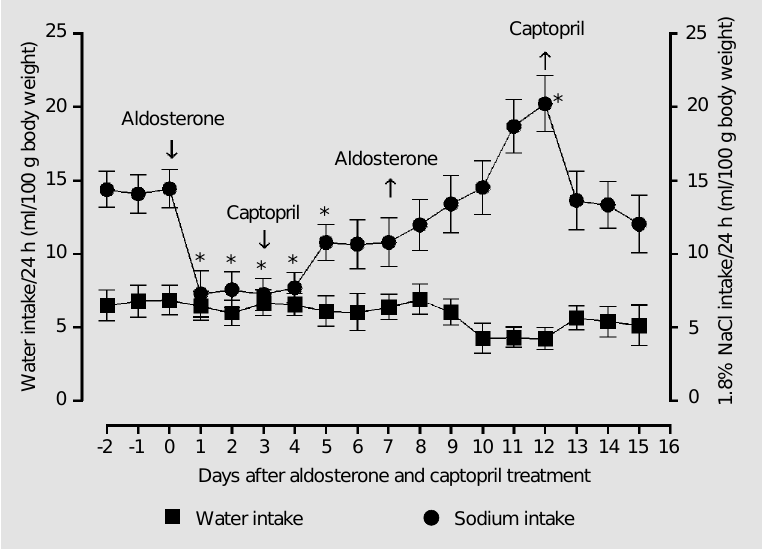
Figure 2 - Influence of aldosterone administration (100 µg/kg, sc , for 7 days) on water (squares) and 1.8% NaCl intake (circles) of hypothyroid rats before and after captopril treatment (1 mg/g added to the food from day 3 to day 12). Arrows represent days on which aldosterone and captopril were given or interrupted. *P<0.05 compared to day zero (ANOVA and